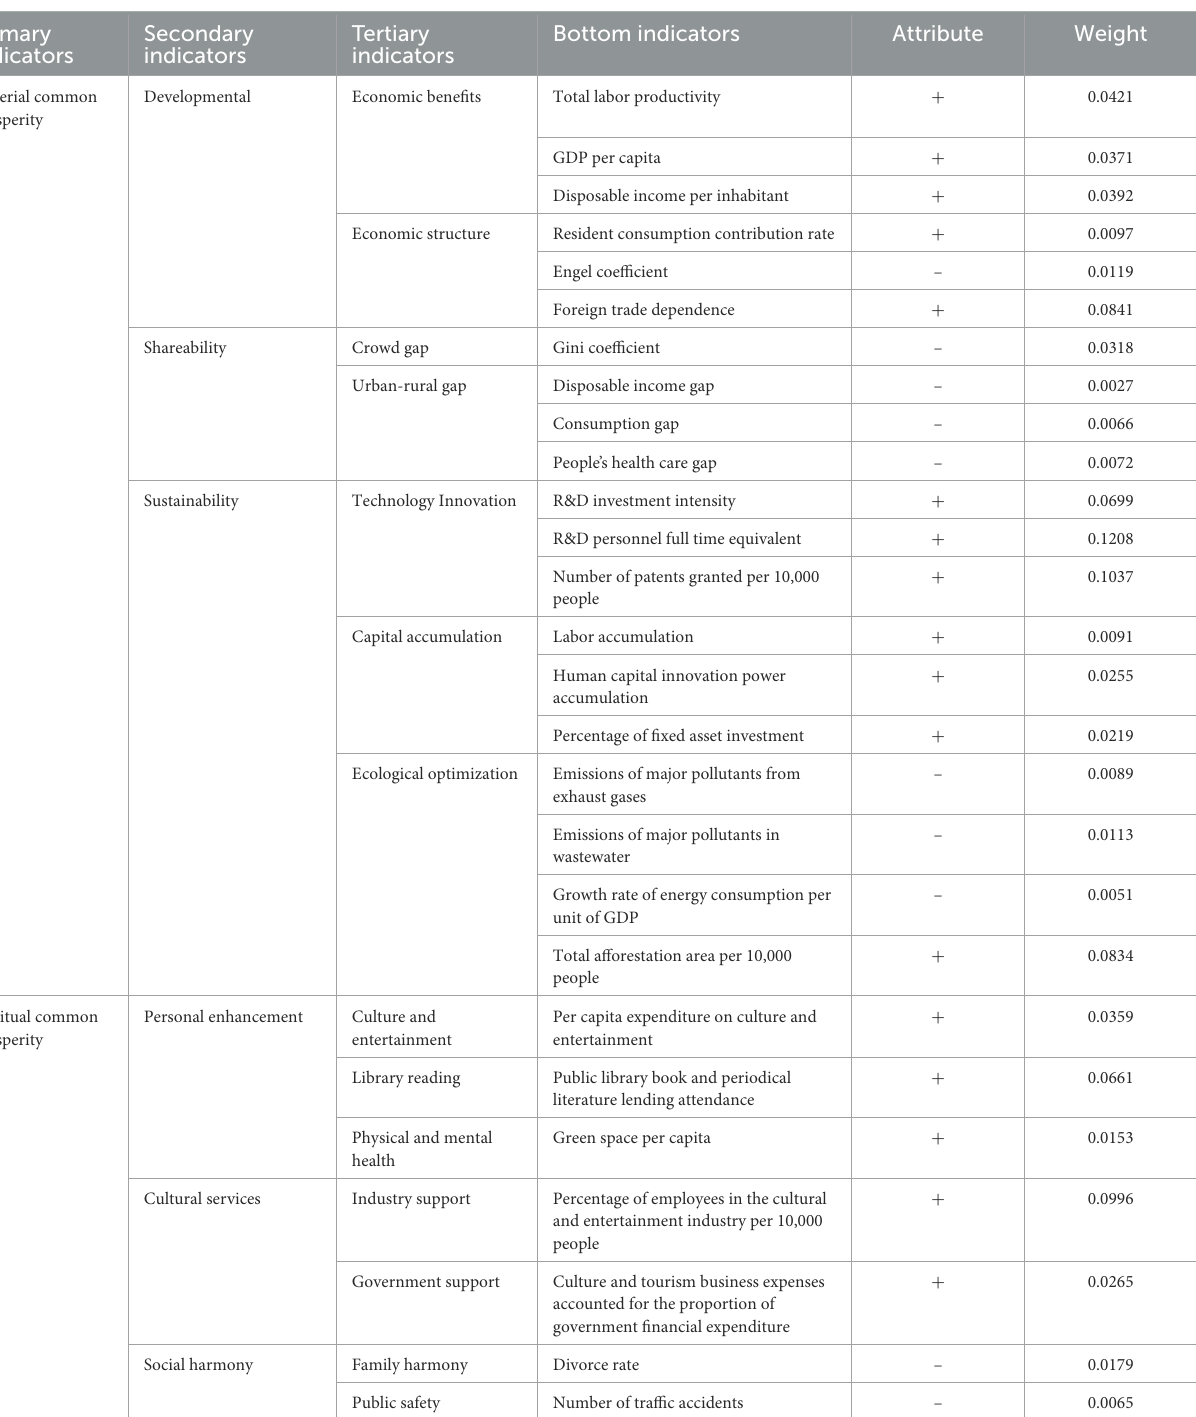
TABLE 1 Evaluation system of the level of common prosperity realization in